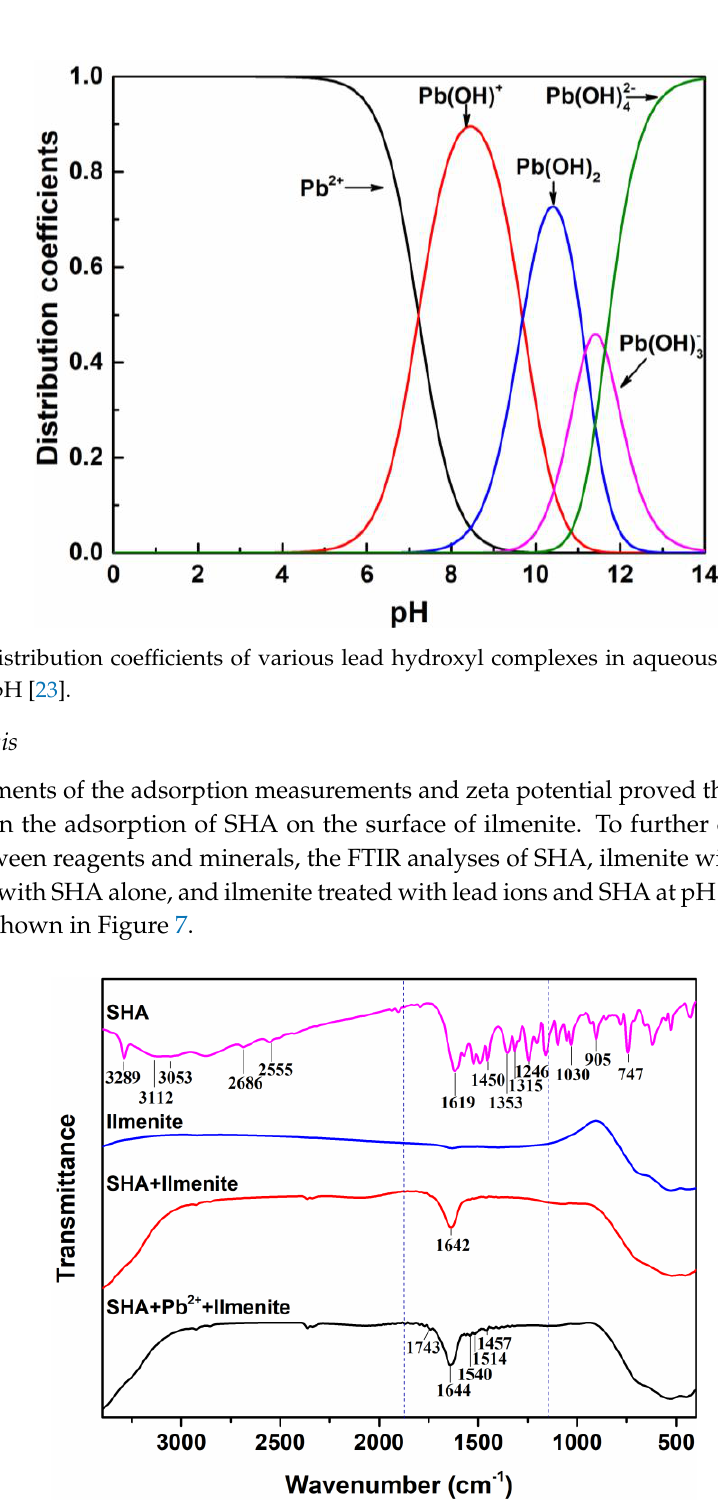
Figure 7. FTIR spectra of ilmenite before and after conditioning with Pb 2+ and SHA.